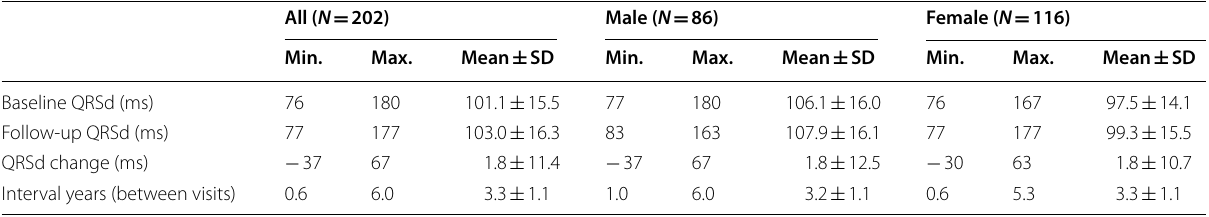
This tables provides QRS duration for the two clinic visits (baseline and follow-up). Also the table calculates QRSd change and interval years between the two clinic visits